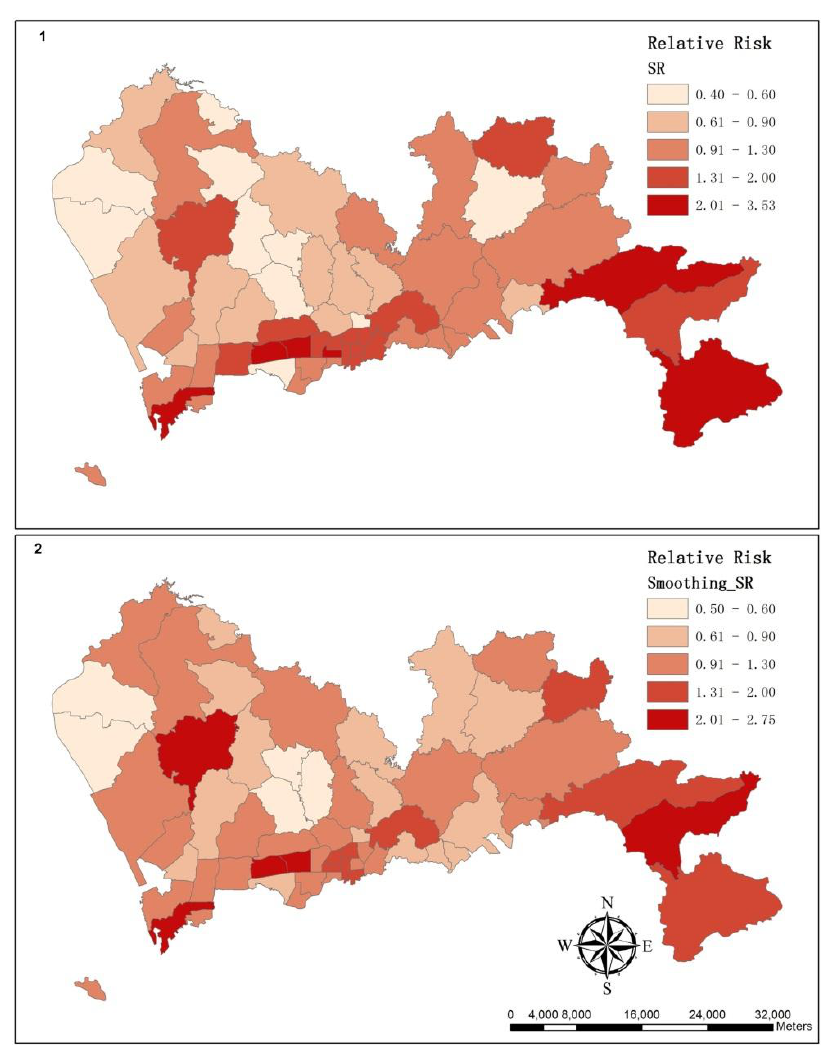
Figure 5. These maps illustrate the spatial variation of relative risk: ( 1 ) a map of the SR; ( 2 ) a map of the smoothing SR.